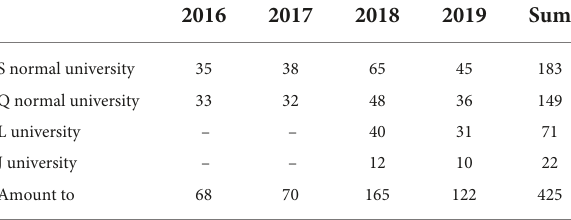
TABLE 2 Statistical map of the distribution of the number of